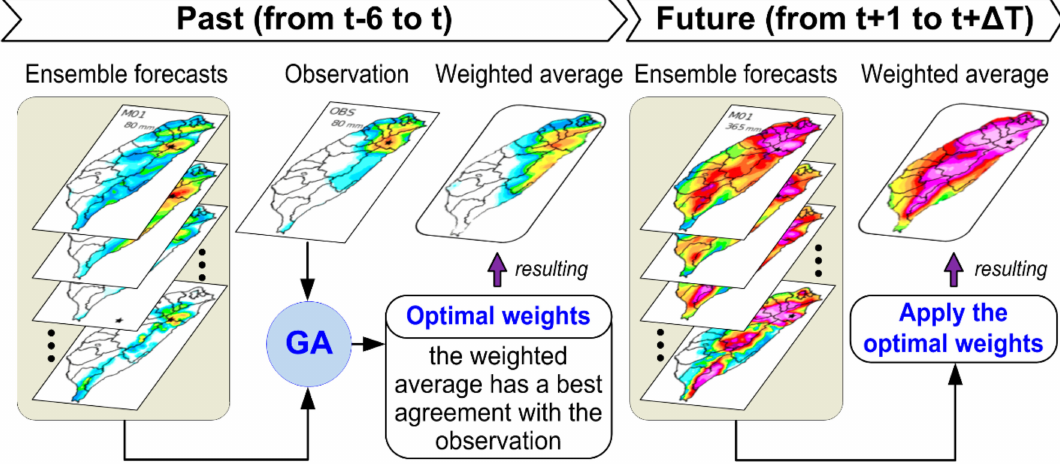
Figure 3. Illustration of the proposed genetic algorithm (GA)-based methodology for providing effective quantitative forecasts of 24 h typhoon